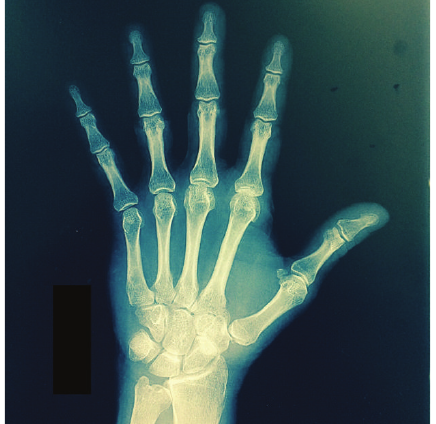
Figure 3: Left windblown hand.